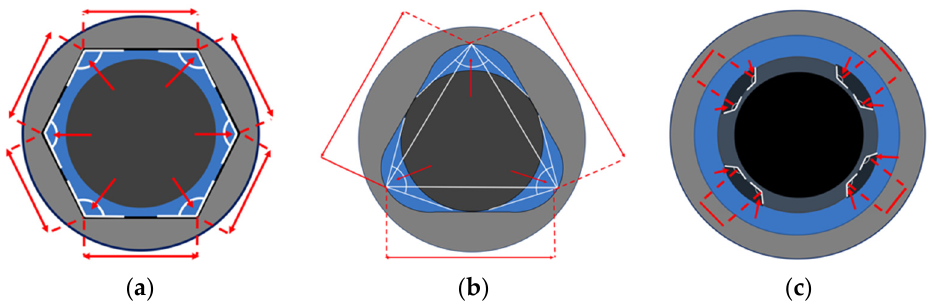
Figure 1. ( a ) Variables evaluated in Group A (Internal hexagon). The angles formed between the sides of the hexagon were located and measured. The length of the hexagon sides was also measured to determine changes at the internal connections (IC) geometry. ( b ) Variables evaluated in Group B (Internal Three-Channeled). The lobe angle was located with the vertex at the most convex portion of the channel and the sides at the base of the channel walls. The length of the wall was estimated by connecting the vertex of each channel to create a triangle. Each side of the triangle was considered for the evaluations. ( c ) Variables evaluated in Group C (Internal Four-Channeled). The anti-rotational features are small boxes protruding from the IC walls to the center of the implant connection. The internal angles of the boxes were measured. The length of the inner wall of each box was measured.